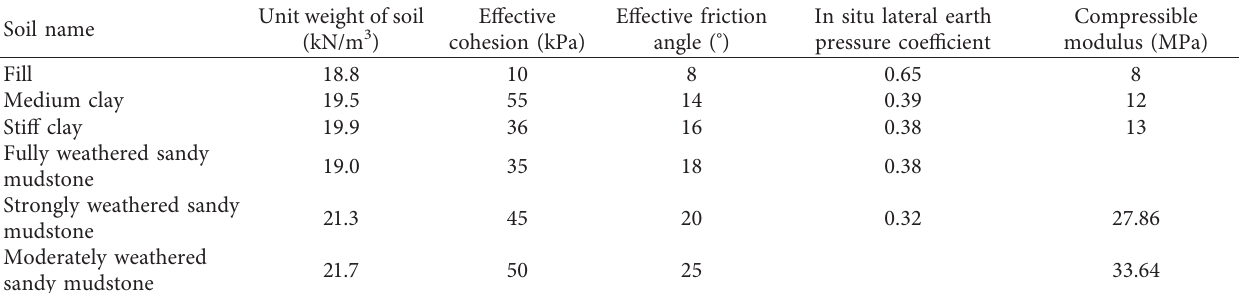
Table 1: Soil layer properties within the site.